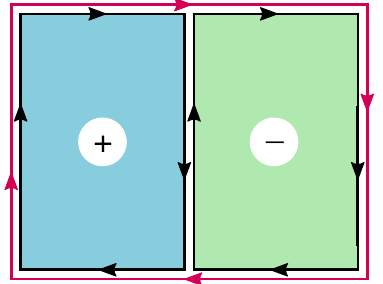
FIG. 11. Charge chiral mode at the boundary and Majorana modes, both at the edge and at the domain wall in the bulk of the